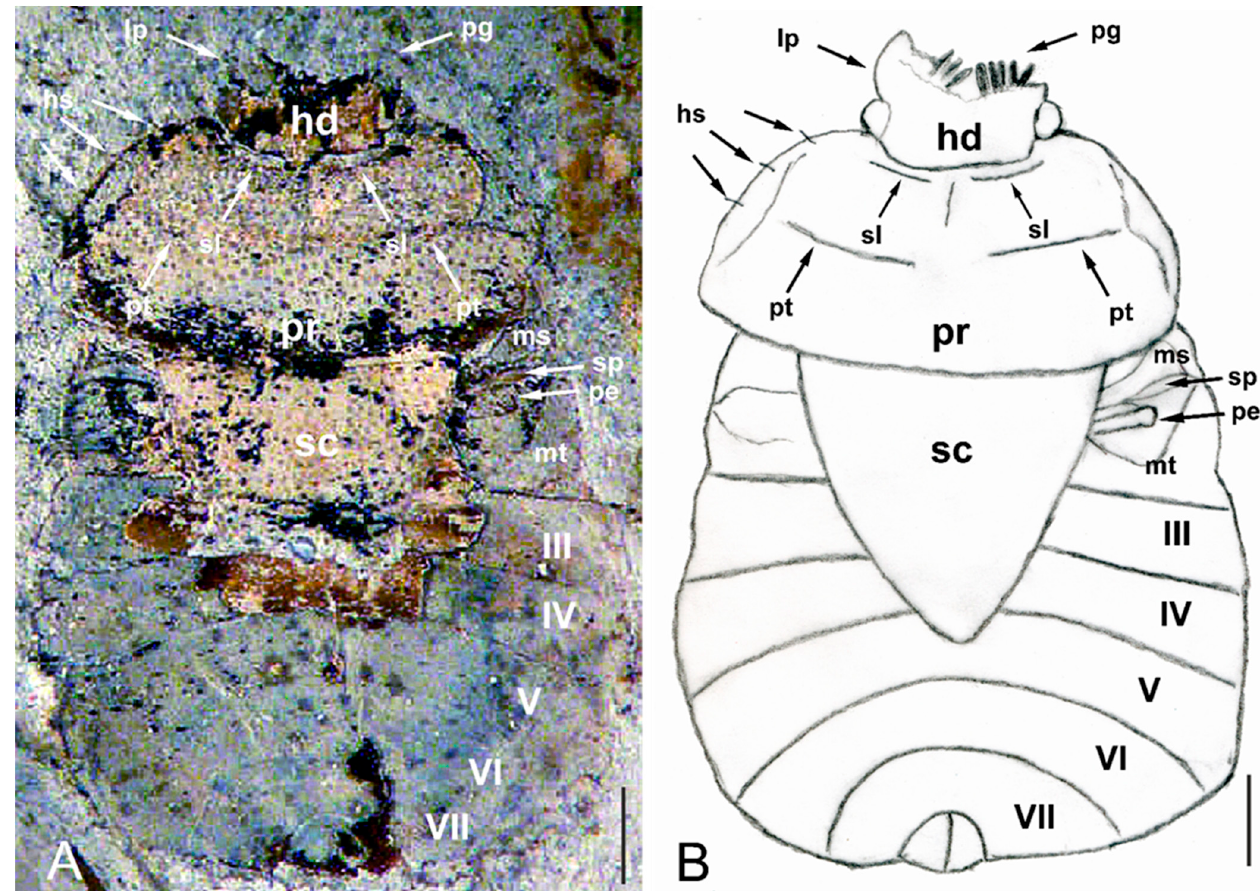
Figure 2. Holotype specimen of E. lisi , dorsal view. ( A ) Original photograph [7], modified; courtesy of the Cambridge University Press. ( B ) Line-drawing reconstruction (by J.A. Lis). Head (hd), hair-like setae (hs), lateral margin of left paraclypeus (lp), mesopleuron (ms), metapleuron (mt), peritreme (pe), pegs (pg), pronotum (pr), postmedian transverse depression (pt), scutellum (sc), submarginal impressed line (sl), metathoracic spiracle (sp), abdominal segments from III to VII (I–VII). Scale bars = 1.0 mm.